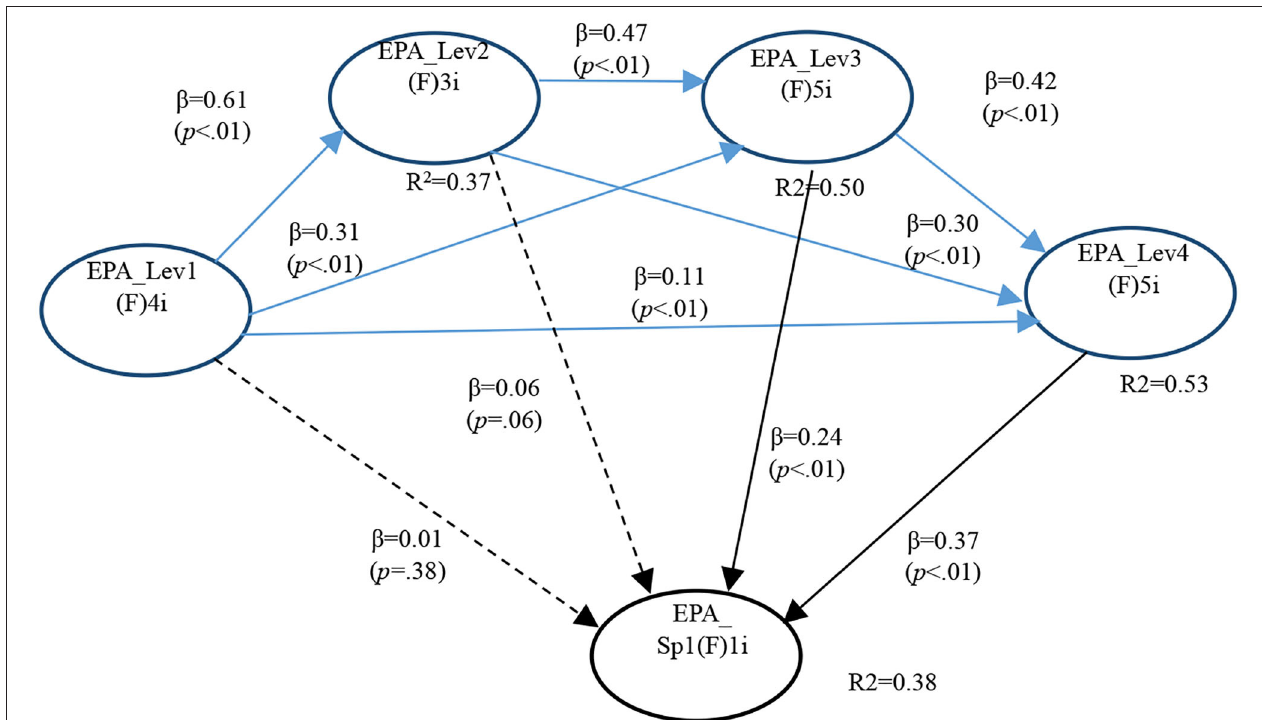
FIGURE 1 | Full model for GI EPA